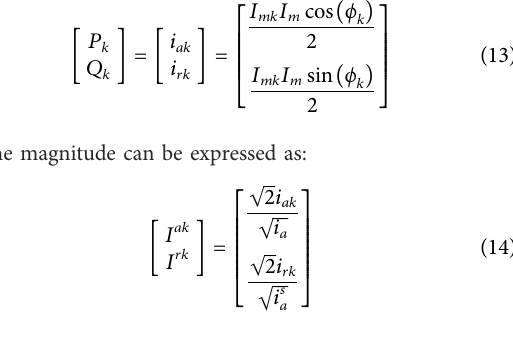
FIGURE 9 The proposed experimental system.